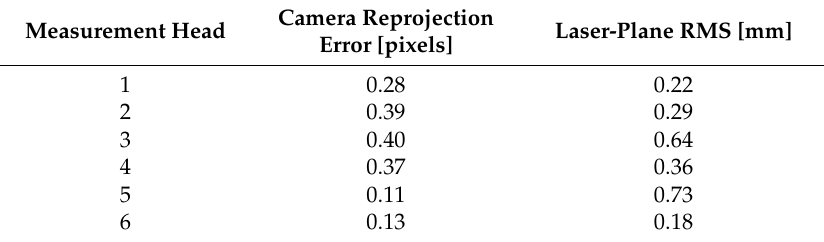
Table 2. Local calibration accuracy evaluation of each system.